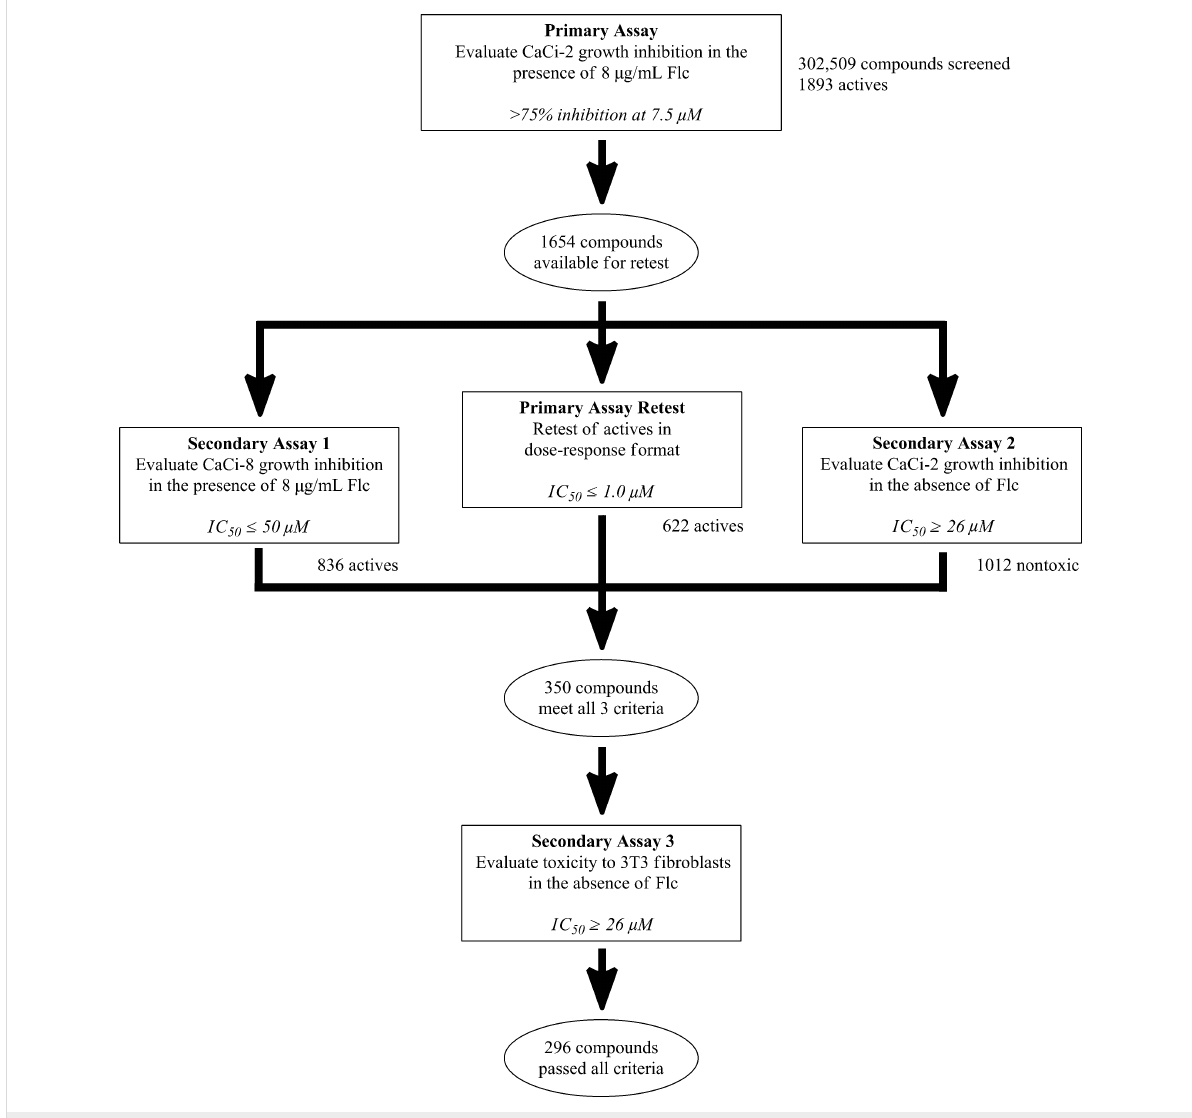
Figure 1: Assay pipeline for triaging hits. Individual assay cut-offs are given in